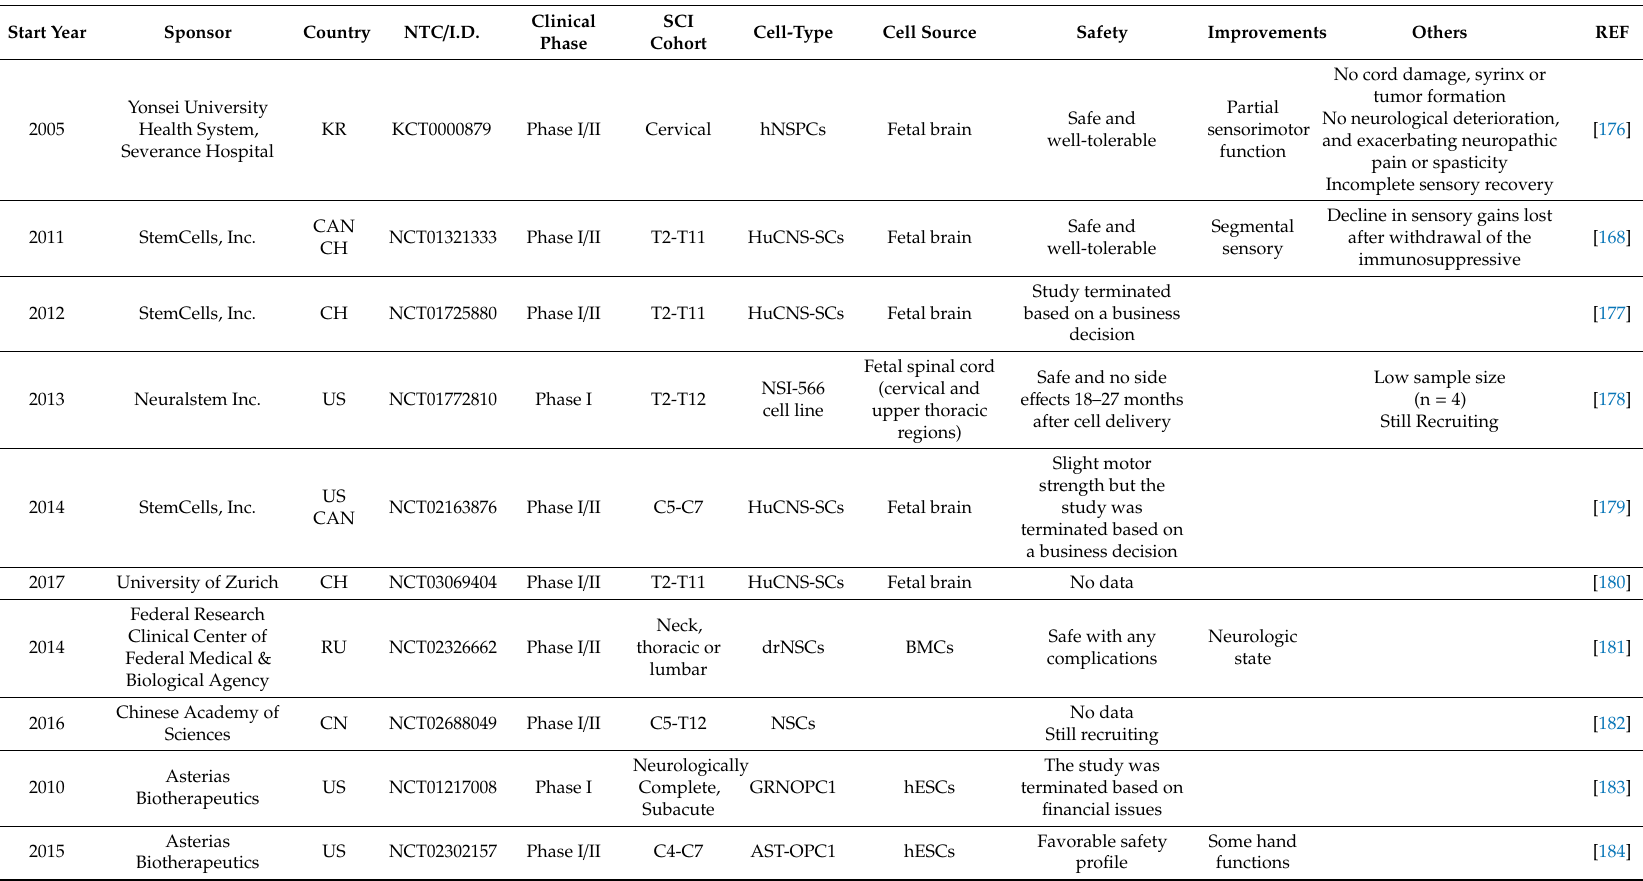
Table 3. Spinal Cord Injury Clinical Trials using NSC-based